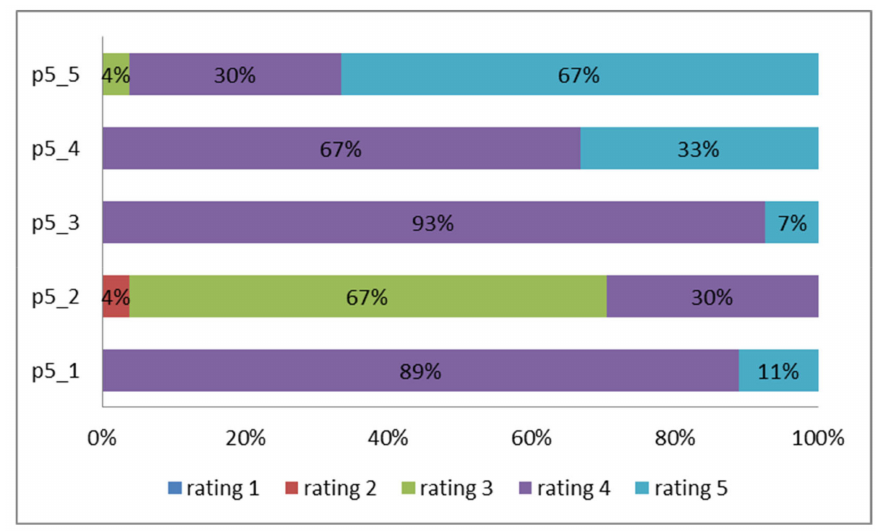
Figure 6. Assessment of reasons for the coal power industry to implement CE.